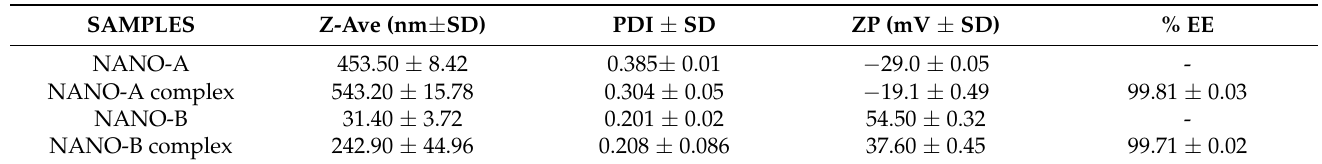
Table 1. Physico-chemical and technological characterization of nanomedicines and nanocomplexes obtained with polymeric (NANO-A) and lipidic (NANO-B) raw materials. Each value is expressed as mean ± SD from at least three